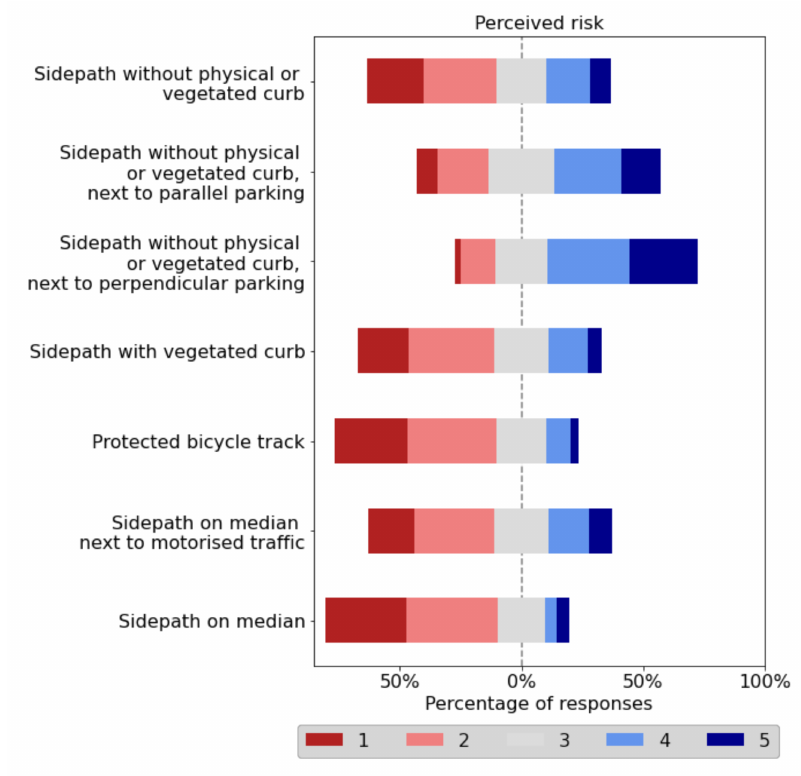
Figure 7. Results of perceived risk during meeting